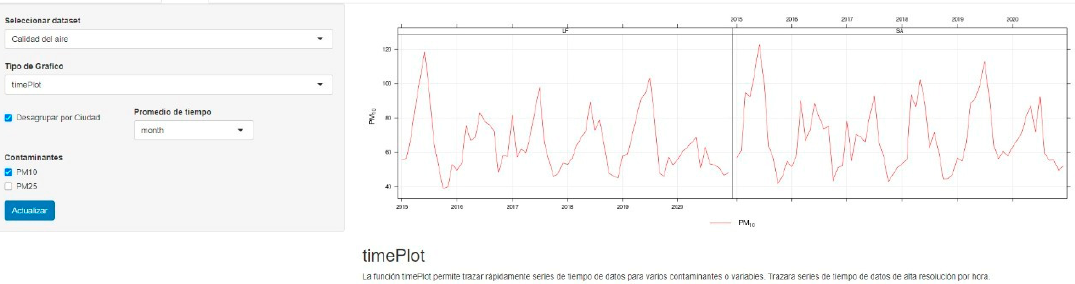
Figure A1. User interface demonstration for request the parameters “PM10”, “PM25”, “ws” (wind speed), and “wd” (wind direction) for the monitoring stations “Parque O’Higgins” and “La Florida” between 2015 and 2020.